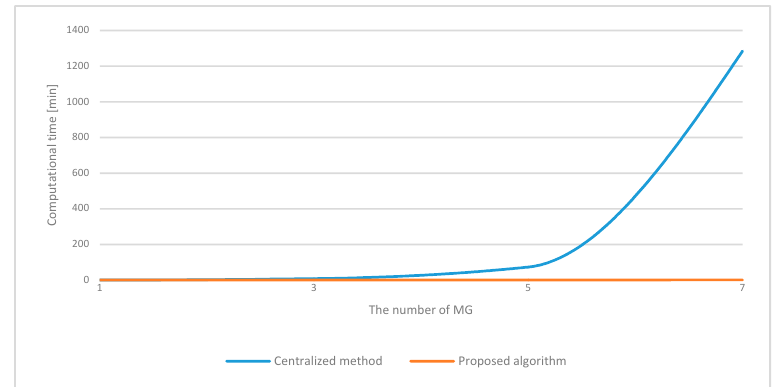
Figure 13. Computation time according to the number of microgrids using centralized method.